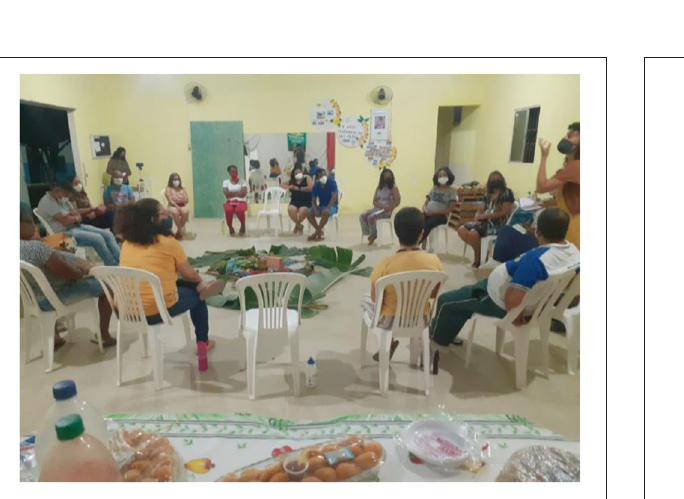
FIGURE 4 | Artist and illustrator Flávia Bomfim drew faces of community members and researchers to connect with each CAG member.